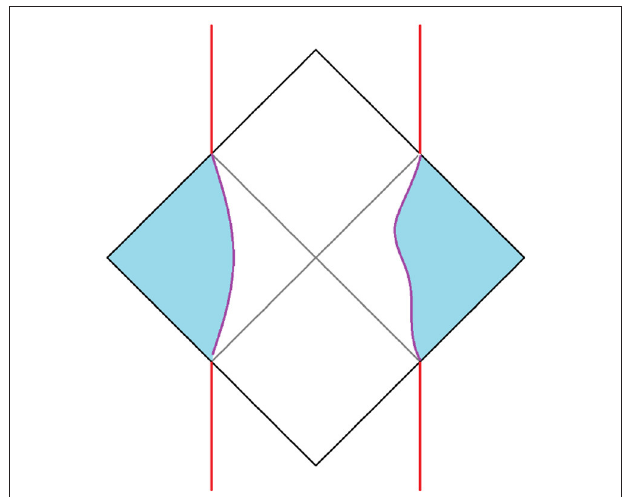
FIGURE 2 | Penrose diagram for a NERN black hole. The curved lines represent the trajectory of the black hole boundary at r = 2 r + . On the left side the boundary is shown in its equilibrium location while on the right it is moving in reaction to some matter.